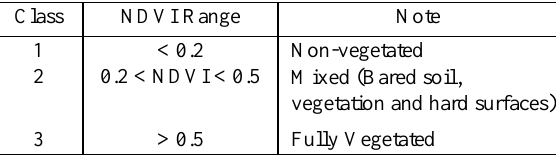
Table 1. NDVI Classification